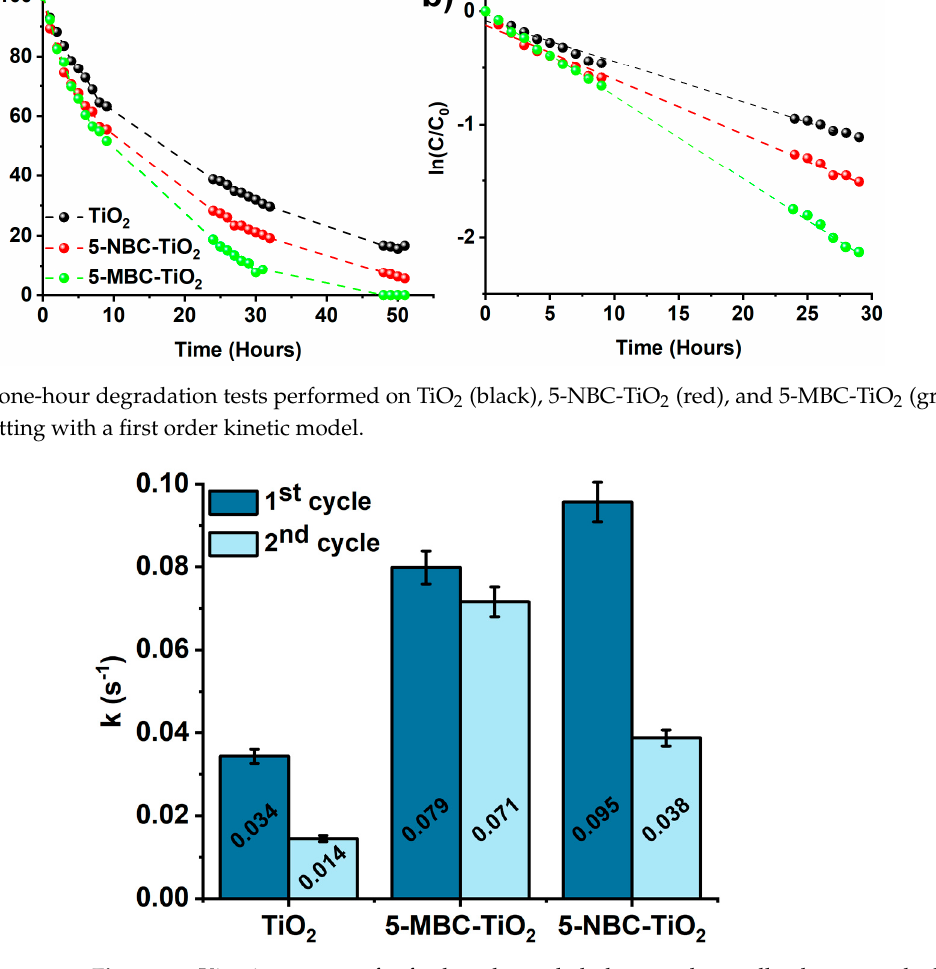
Figure 10. Kinetic constants for fresh and recycled photocatalysts: all values are calculated from the data collected within the first 3 h of reaction under mild conditions.